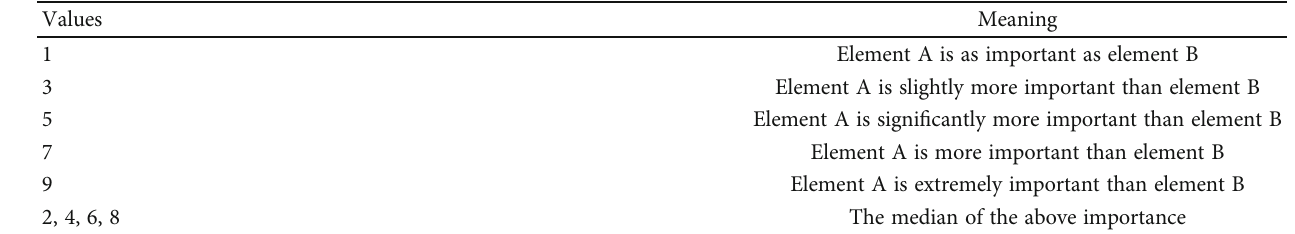
Table 1: Importance.